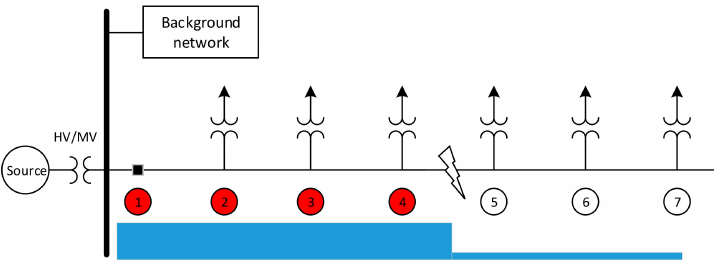
Figure 8. Negative sequence current magnitude along the feeder following a single-phase to ground fault